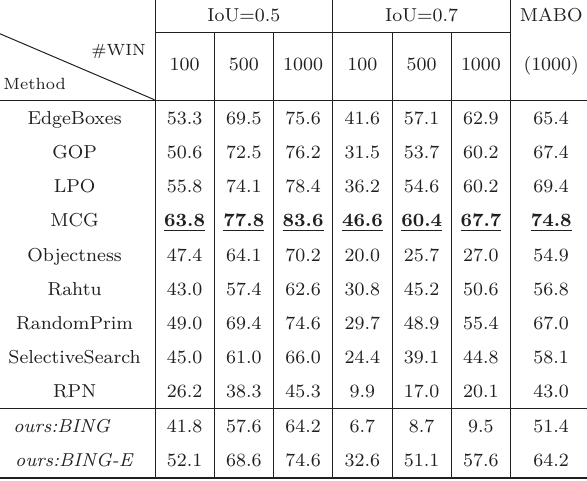
Table 7 Detection recall (%) using different IoU thresholds and #WIN on COCO validation set IoU=0.5 IoU=0.7